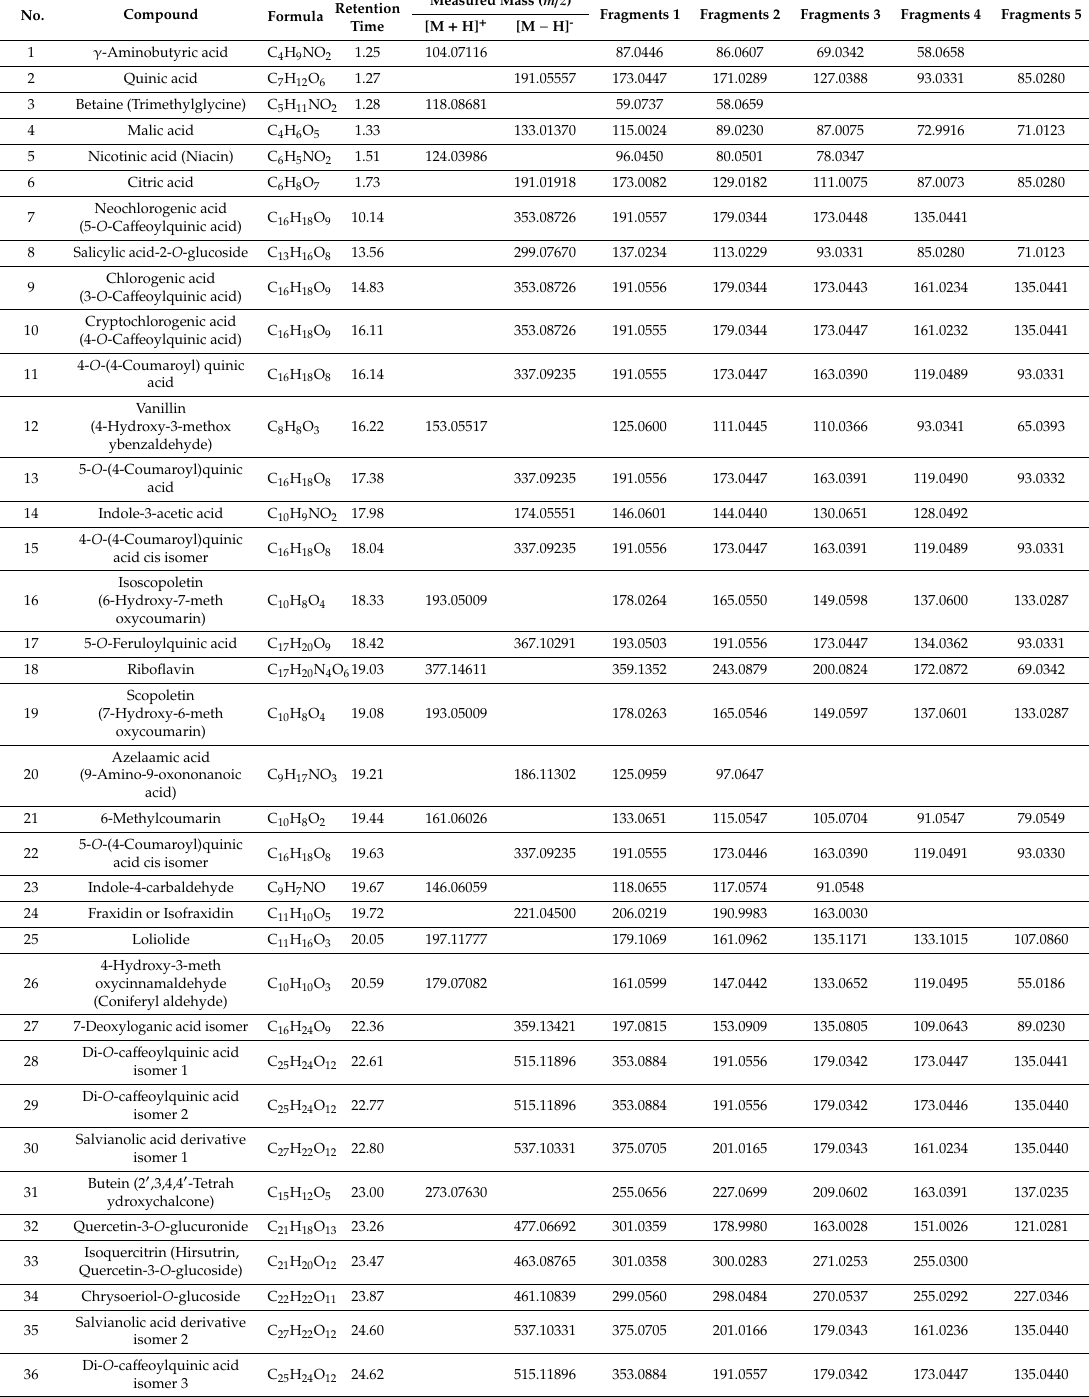
Table 3. Chemical composition of Jerusalem artichoke leaf protein concentrate (JAPC) extracted from green